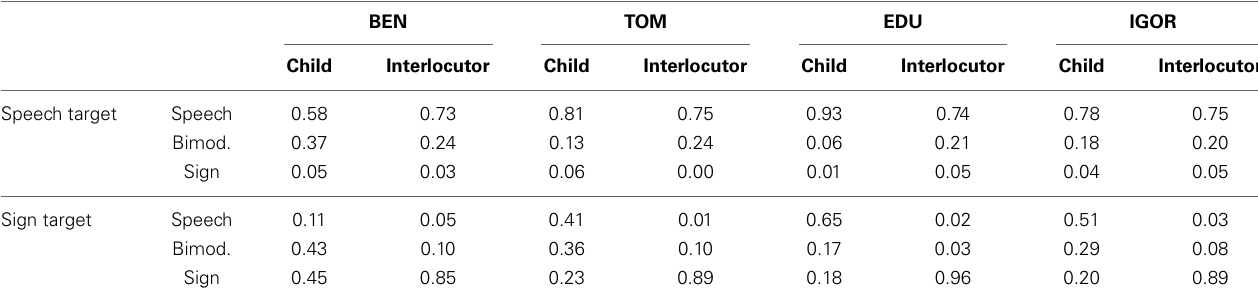
Table 2 | Overall